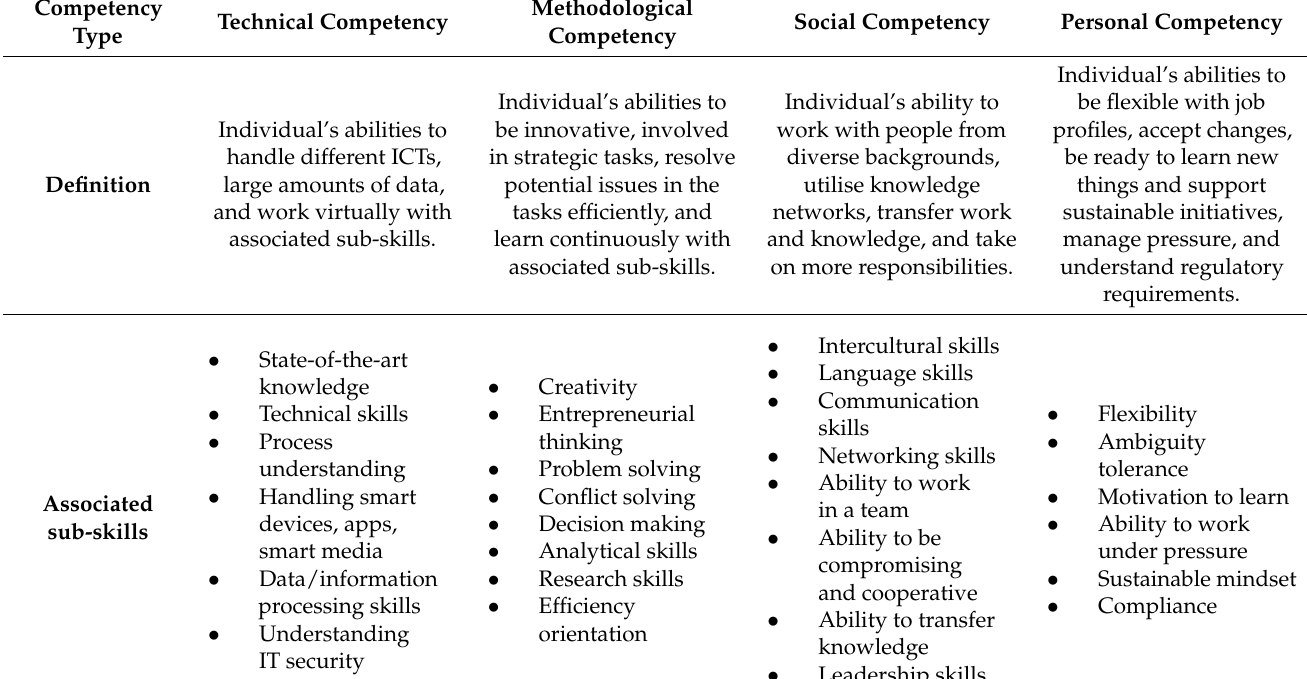
Table 1. Modified competence framework based on Hecklau